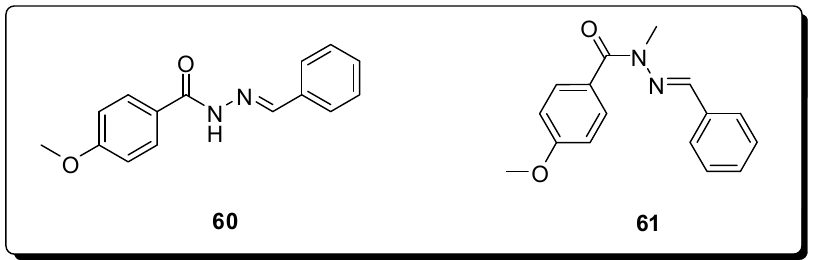
Figure 19. N -acylhydrazones with analgesic activity.